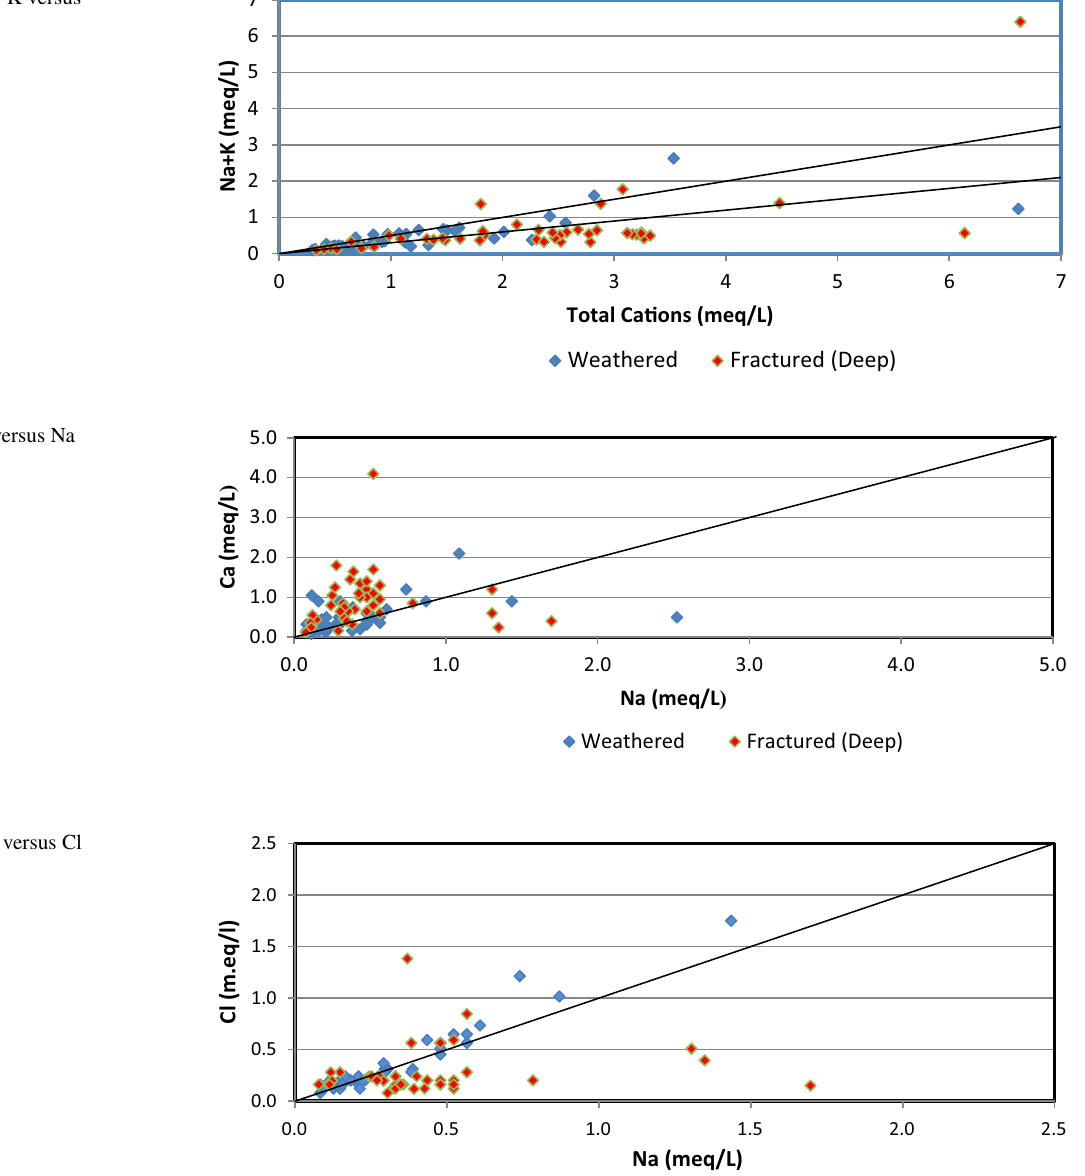
Fig. 9 Plots of Ca versus Na